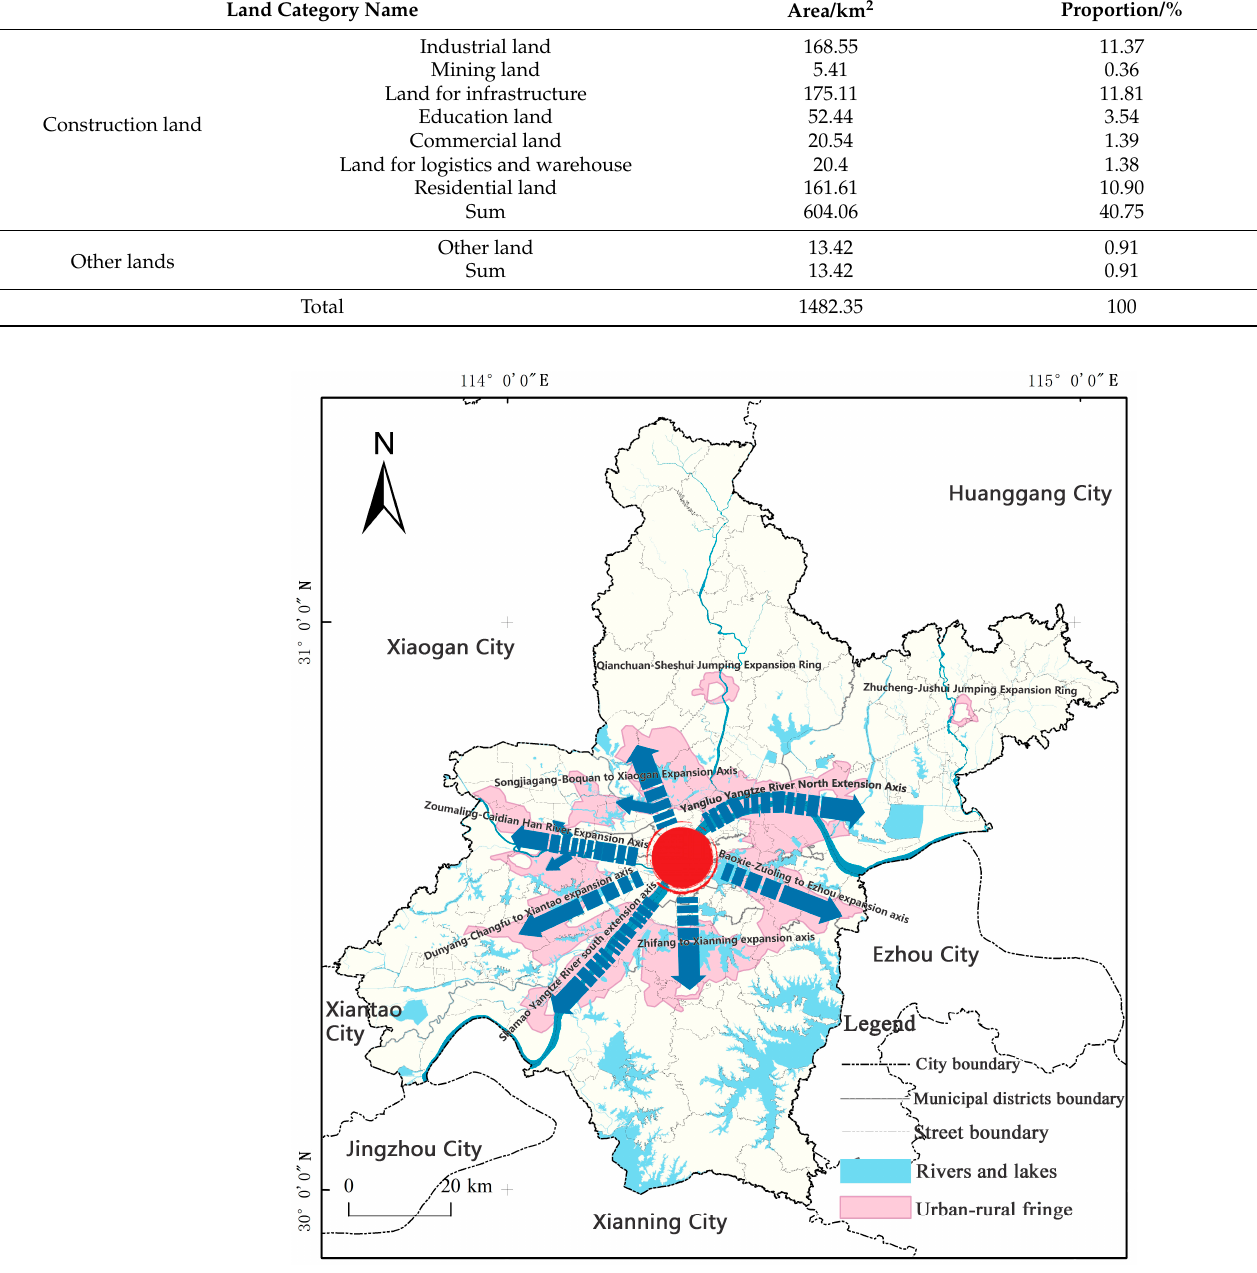
Figure 13. Spatial form of Wuhan Urban-Rural Fringe.